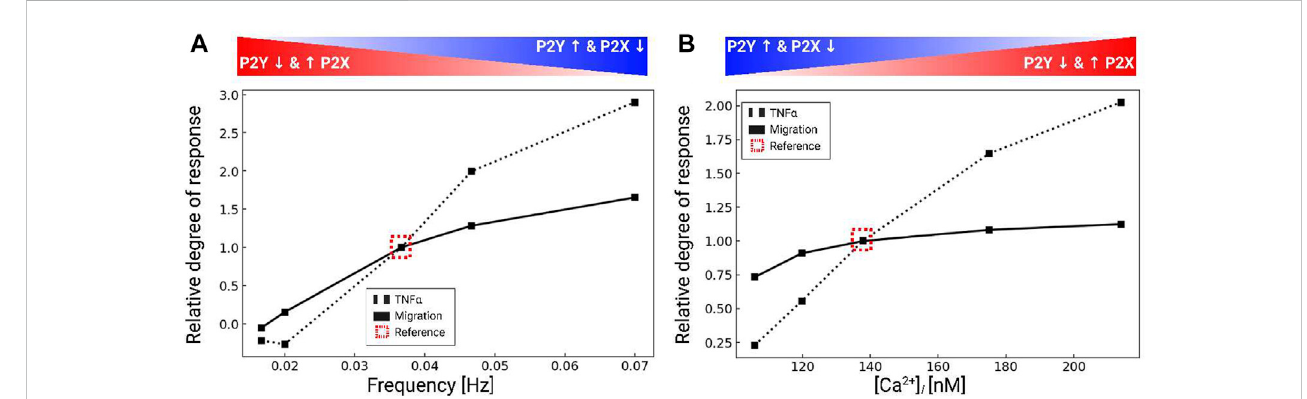
FIGURE 6 Predicted TNF α production (black dashed) and migration (black solid), normalized to control conditions (dashed box) in response to variations of the intracellular Ca 2+ waveform frequency (A) and amplitude (B) . All calculations were performed using 200 µM ATP and the data were collected over 5 min after ATP